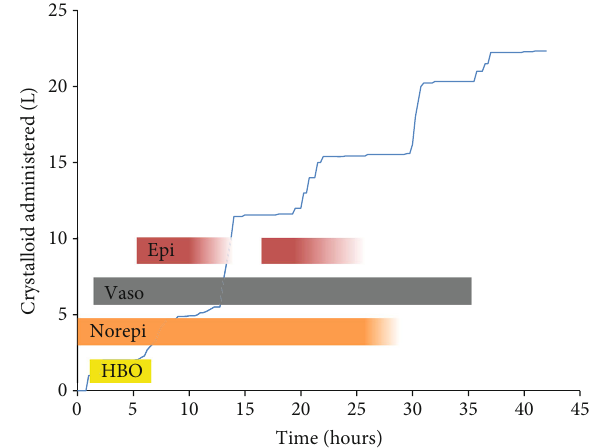
Figure 2: Time course of crystalloid administered upon arrival at the medical center with hyperbaric capabilities. Solid bars show timing of hyperbaric oxygen treatment (HBO) and norepinephrine (Norepi), vasopressin (Vaso), and epinephrine (Epi) infusions. The darkest color intensity indicates maximum vasopressor dose (Norepi, 30 mcg/min; Vaso, 0.04 units/min; Epi, 10 mcg/min), faded intensity indicates taper of dose, and absence of bar indicates discontinuation of vasopressor. Mean arterial pressure (not shown) was 55-65 mm Hg throughout this